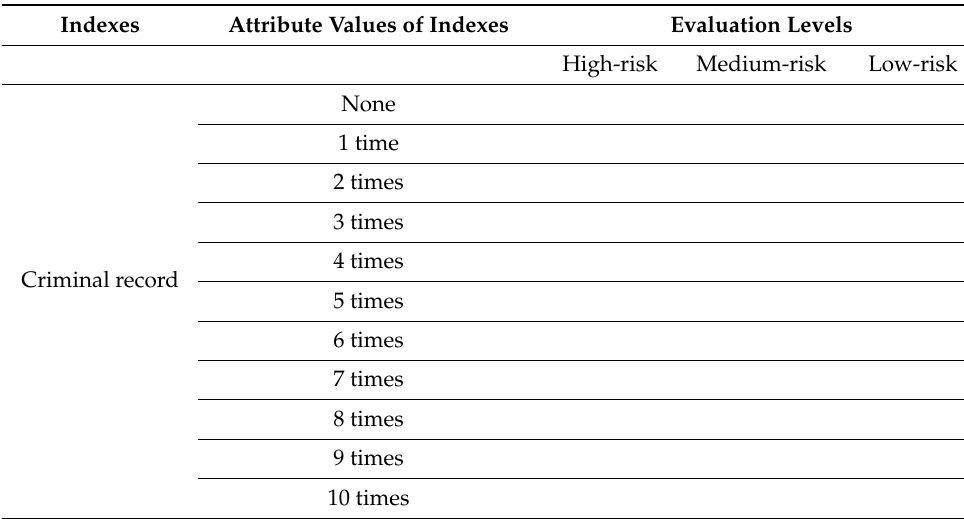
Table A10. Single factor evaluation of personal conduct